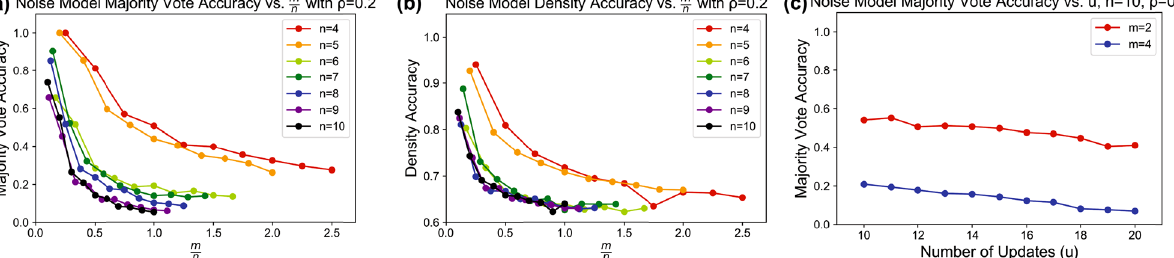
m 4, 5, . . . , 10 1, 2, . . . , 10 and m versus α n . ( b ) Density accuracy = ∈ { } ∈ { } 2 and 10 for m 4 = =